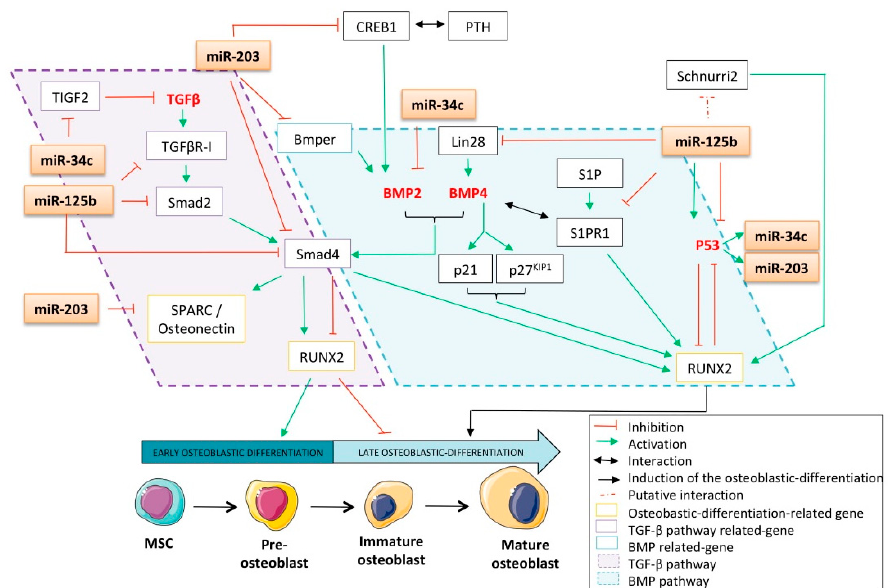
Figure 5. The p53-related miRNAs controls the osteoblastic differentiation through an interplay of both the bone morphogenetic protein (BMP) and the transforming growth factor β (TGF- β ) pathways. Bmper : BMP endothelial cell precursor derived regulator; BMP2 : bone morphogenetic protein 2; BMP4 : bone morphogenetic protein 4; CREB1 : c-AMP responsive element binding protein 1; PTH : parathormone; RUNX2 : runt-related transcription factor 2; SPARC : secreted protein acidic and rich in cystein; S1P : Sphingosine 1 phosphate; S1PR1 : Sphingosine 1 phosphate receptor 1; TGF- β : transforming growth factor β ; TGF β R-I: transforming growth factor β geceptor I.